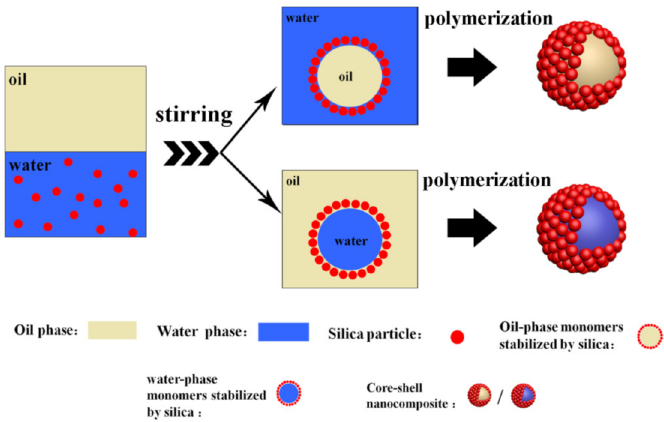
Figure 1. Mechanism of Pickering stabilization